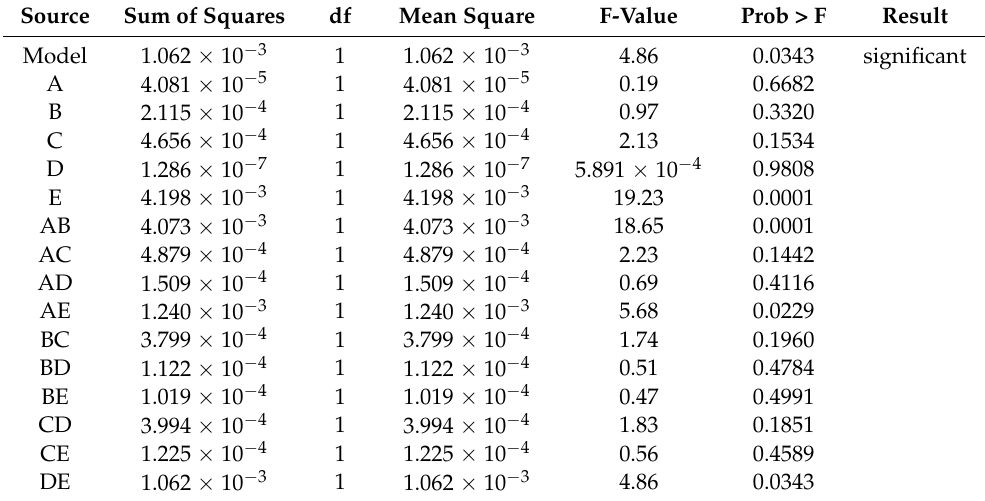
Table 8. Significance test of the full engagement time regression model.